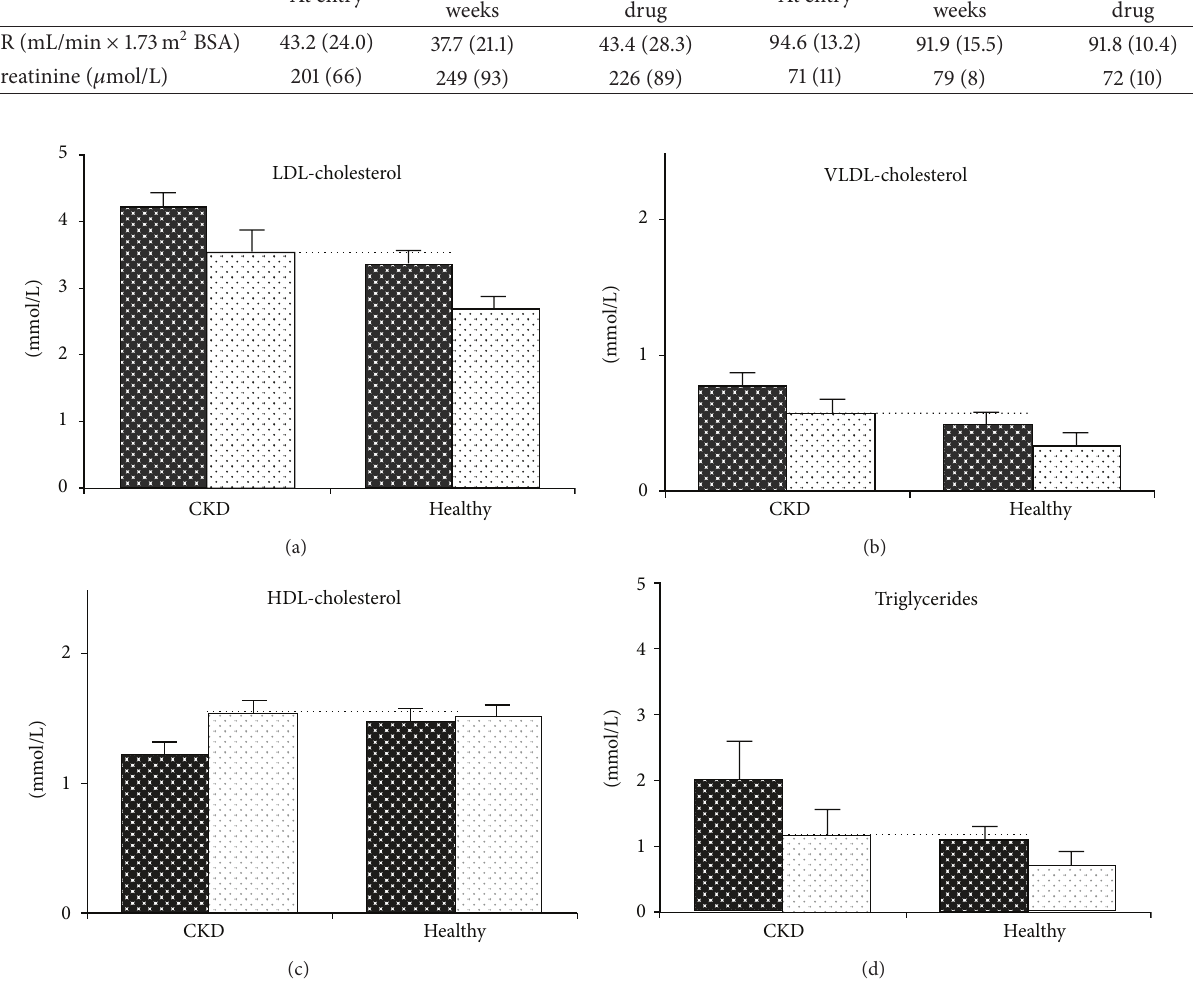
Figure 1: Plasma lipid concentrations at baseline and after six-week treatment with 1mg tesaglitazar o.d. (mean and standard error of the